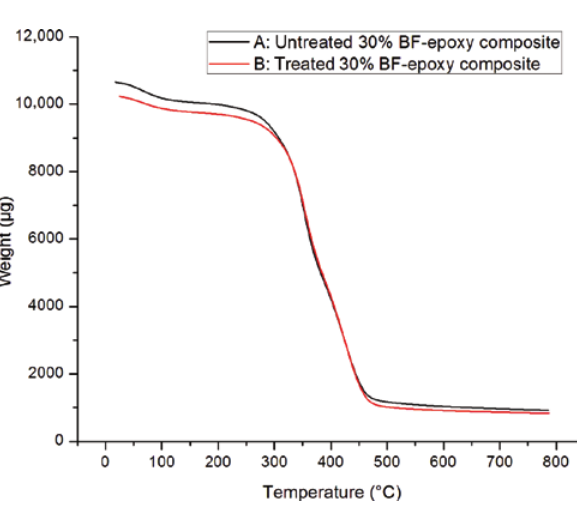
Figure 4: TGA thermogram of untreated and treated 30% BF-epoxy